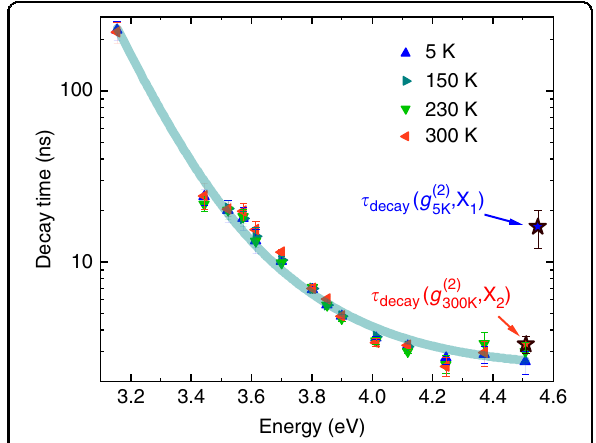
Fig. 11 Evolution of the long-lived component decay time τ L as a function of energy for temperatures ranging between 5 and 300 K. Decay times extracted from g (2) ( τ ) traces measured on QD A at 5 K and at RT are also reported for comparison (blue and red stars). The solid line serves as a guide to the